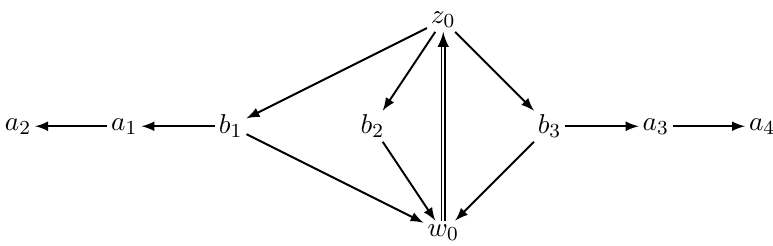
shaped clusters with a doubled arrow between two cluster A -coordinates, w Figure 2 . The E (1 , 1) 7 and z . By mutation on the a nodes we generate an A 0 i same w , z and b nodes. Frozen nodes are omitted 0 0 i